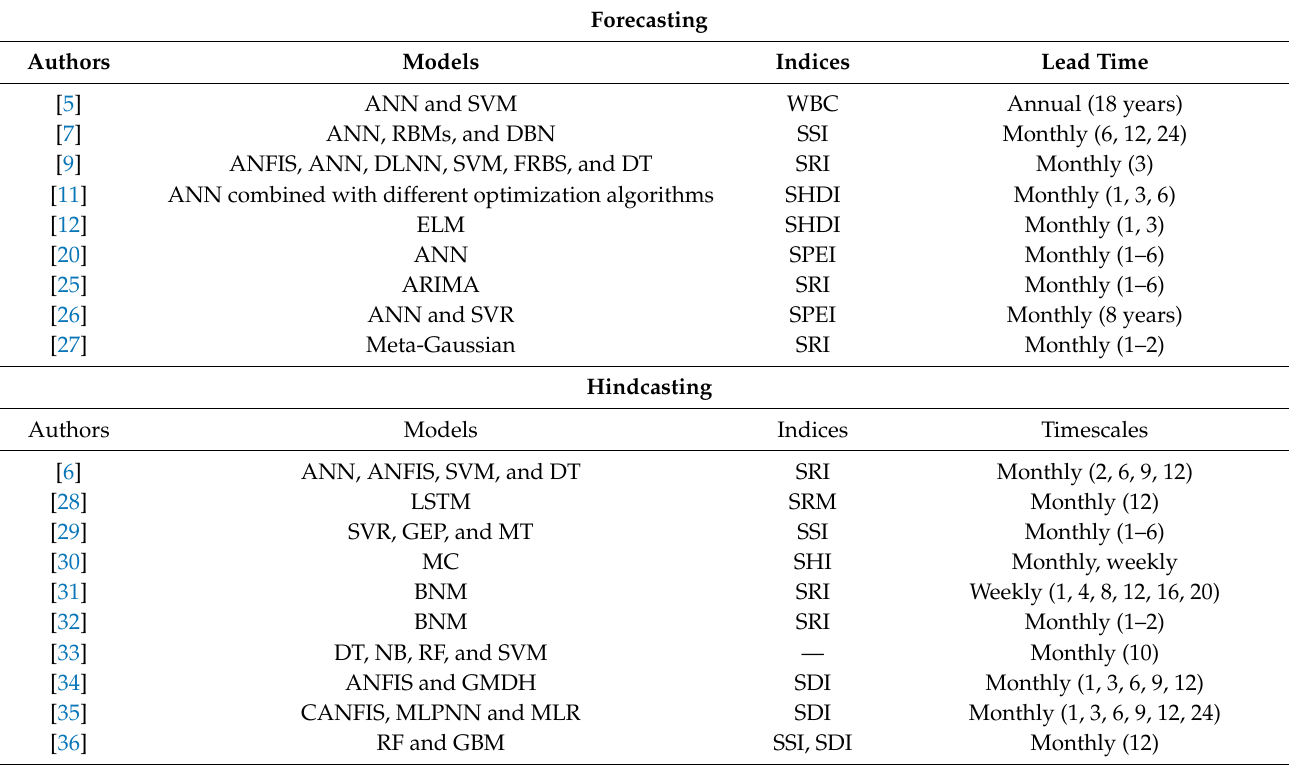
Table 1. Machine and DL models used in hydrological hindcasting and forecasting.